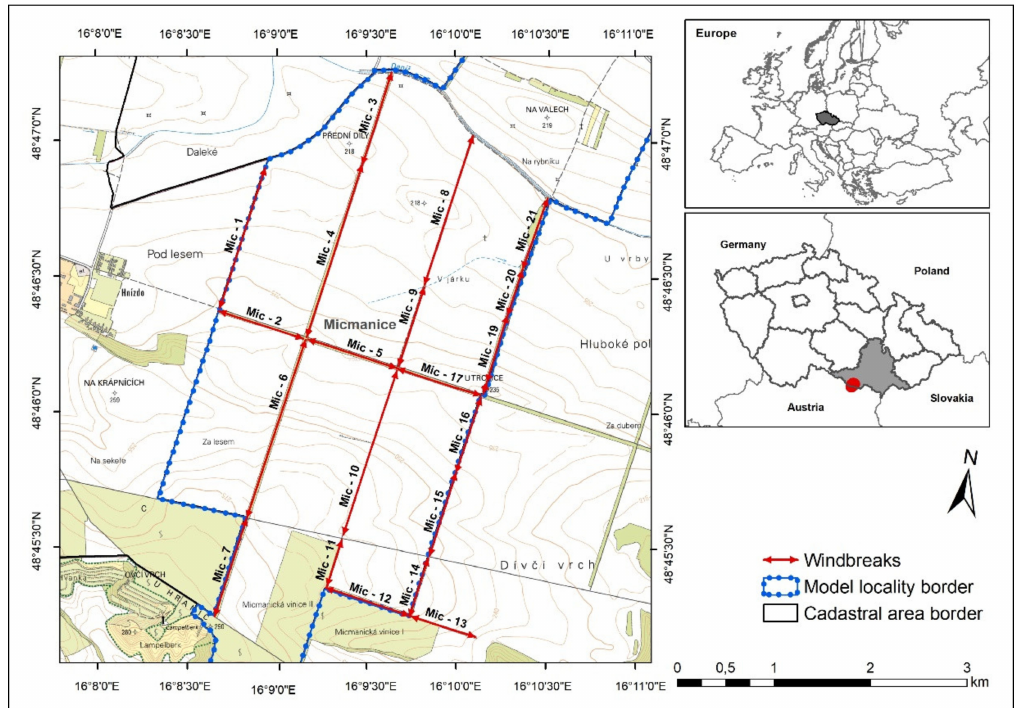
Figure 5. Study locality